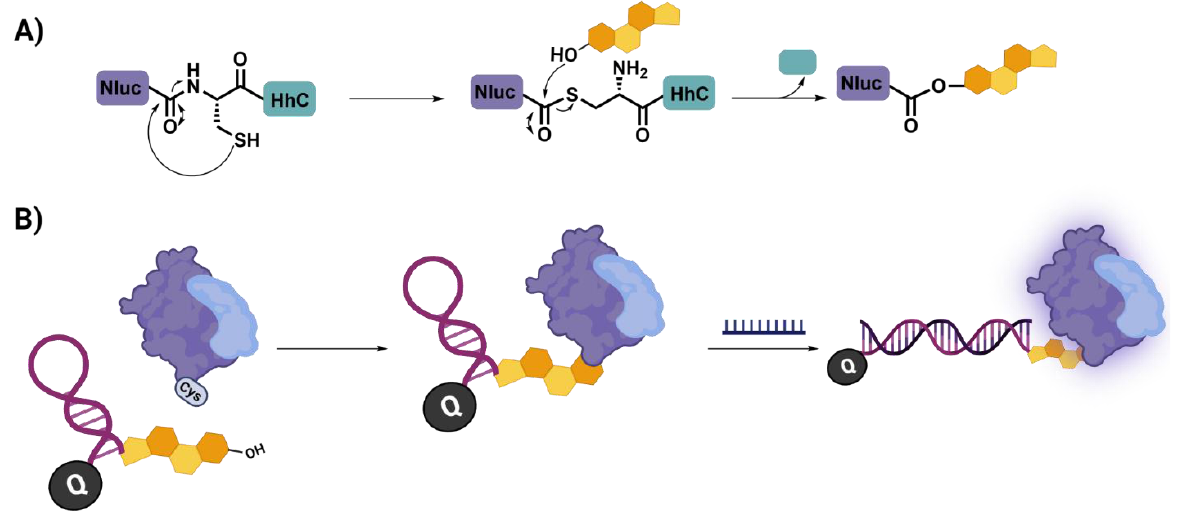
Figure 7. Case Study 4: hijacking post-translational processing to facilitate conjugation. ( A ) the HhC domain undergoes self-splicing and is liberated from an N-terminal fusion protein by the addition of an incoming sterol. ( B ) This can be exploited for the synthesis of nucleic acid sensing enzymatic beacons.